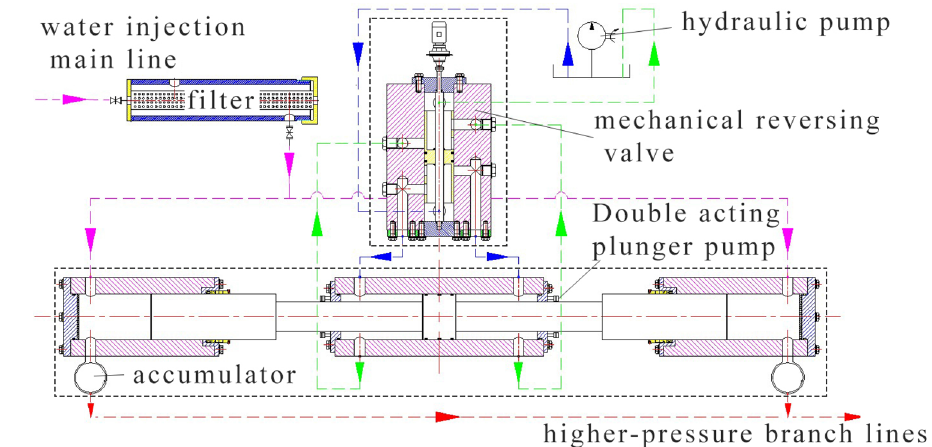
Fig. 2 Overall structure of the